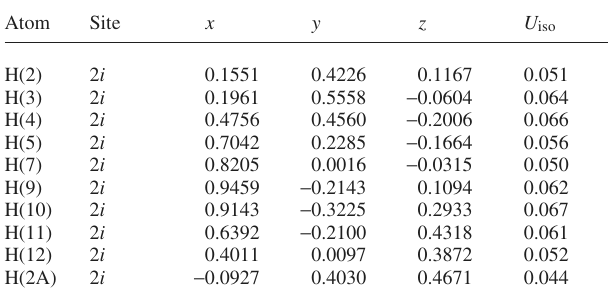
Table 2. Atomic coordinates and displacement parameters (in Å 2 )